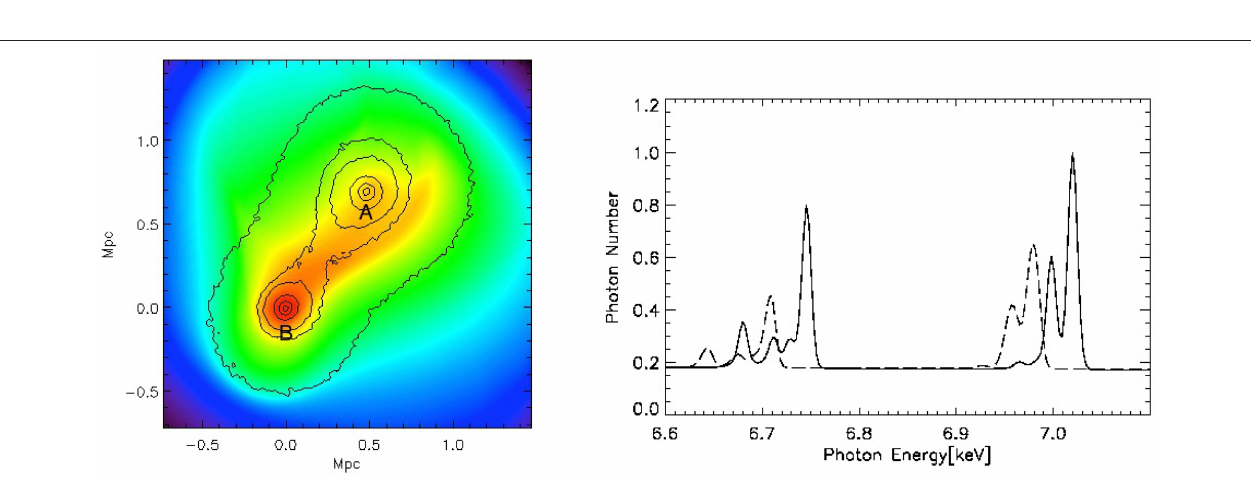
statistical and systematic errors) between these components.